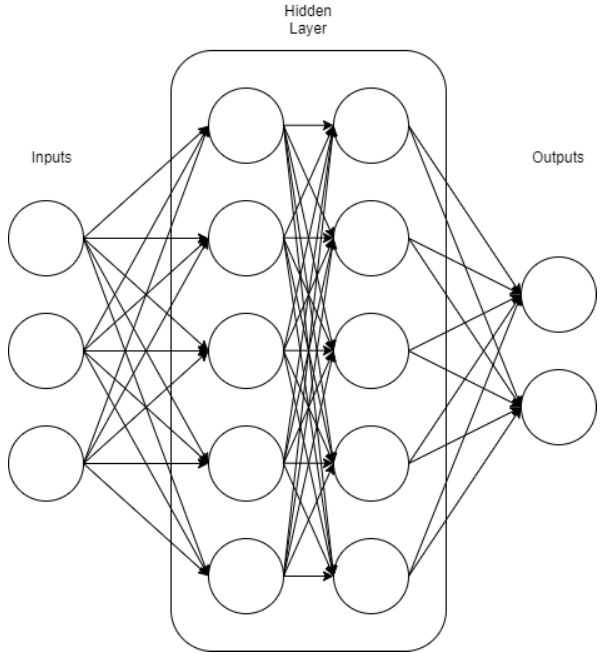
Figure 4. General layout of a Neural Network with two hidden